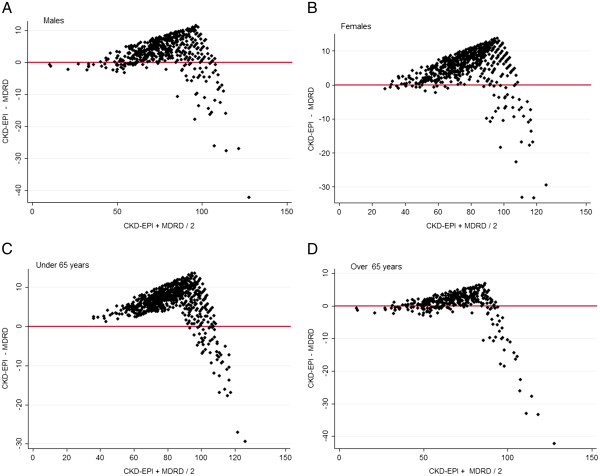
Bland Altman Plots (X axis mean CKD-EPI, MDRD, Y axis CKD-EPI − MDRD) in males.